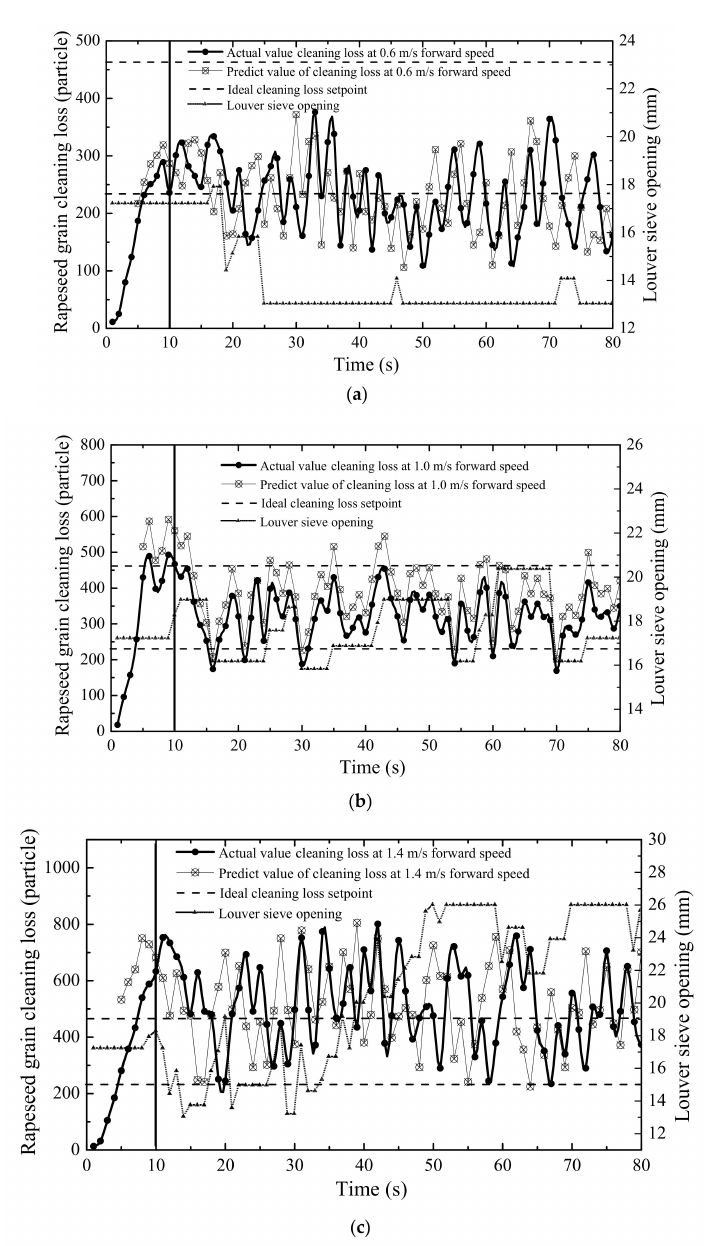
Figure 11. Grain cleaning loss under di ff erent working speeds with the controller switched on. ( a ) Forward speed 0.6 m / s; ( b ) Forward speed 1.0 m / s; ( c ) Forward speed 1.4 m /